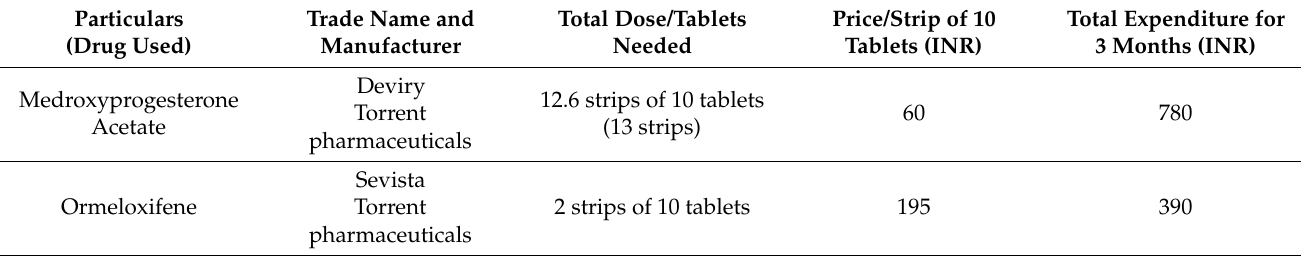
Table 1. Showing the total expenditure on complete dose regimen of two